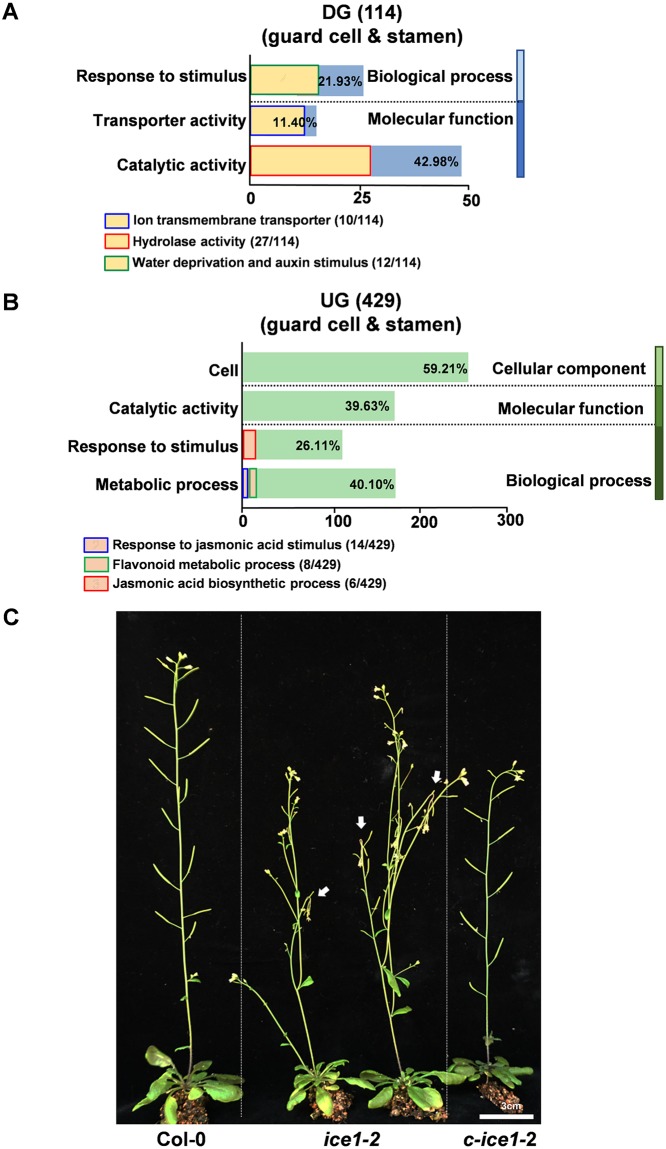
Pathway enrichment and functional category of genes regulated by ICE1 in the anther.(A-B) The enrichment analysis of down-regulated genes (A) and up-regulated genes (B) that are expressed in both of the guard cell and the stamen. The key clusters in the three categories identified by GO are shown in columns. The ratios of each cluster to the total gene number are shown with percentage. (C) Phenotype of impaired ion exchange in the ice1-2 mutant. Arrows indicate the wilted flower buds.